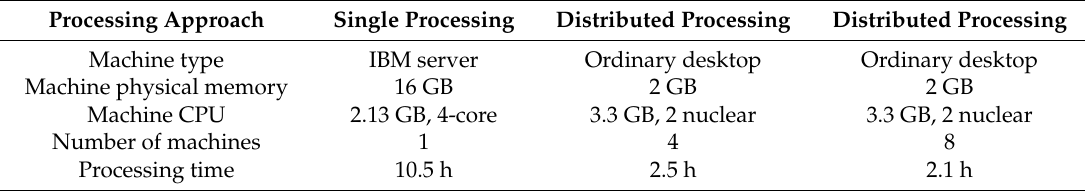
Table 4. Experimental results (2 ◦ × 1 ◦ 20 (cid:48)